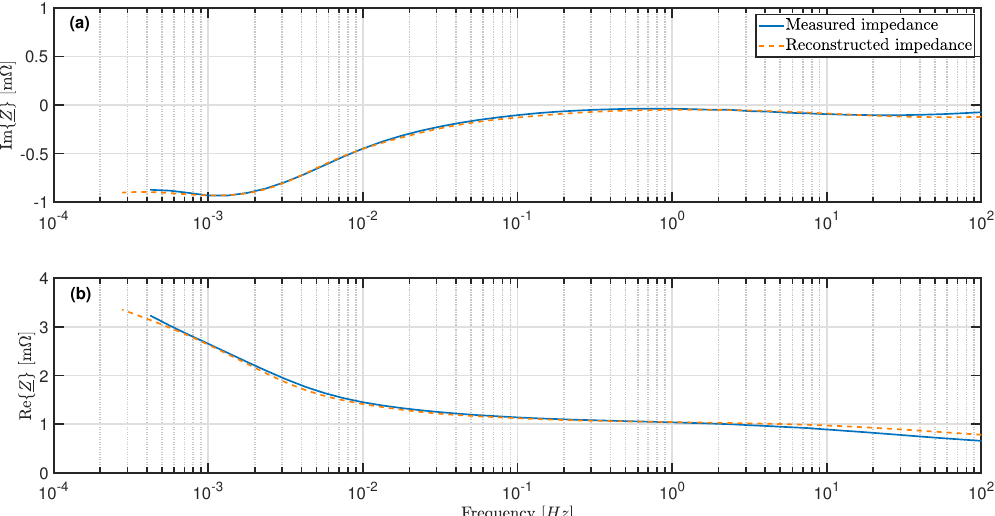
Figure 5. Comparison of measured and reconstructed impedance at 20% SOC ( a ) Imaginary part of impedance. ( b ) Real part of